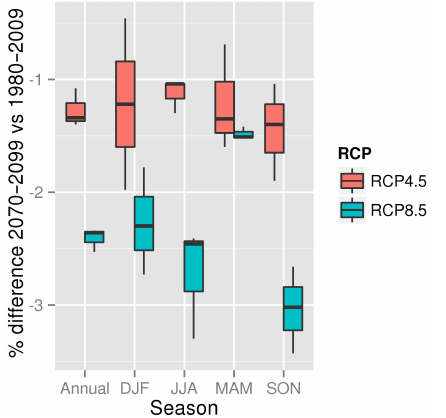
Figure 2. EC-Earth projected changes (%) in the mean 10m wind speed over the North Atlantic Ocean for the period 2070–2099 rel- ative to 1980–2009. Results for both the RCP4.5 (red) and RCP8.5 (blue) future climate scenarios are shown. The whiskers on the boxes show the spread of the results across the ensemble members (three RCP4.5 and three RCP8.5